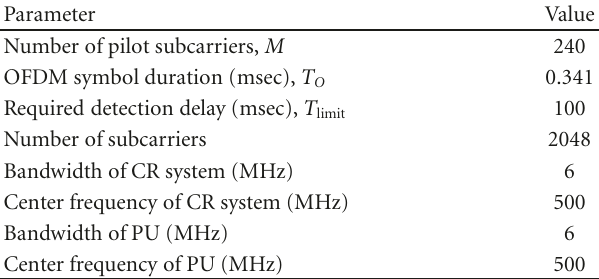
Figure 4: Miss detection probability according to false alarm probability (QP: quiet period).